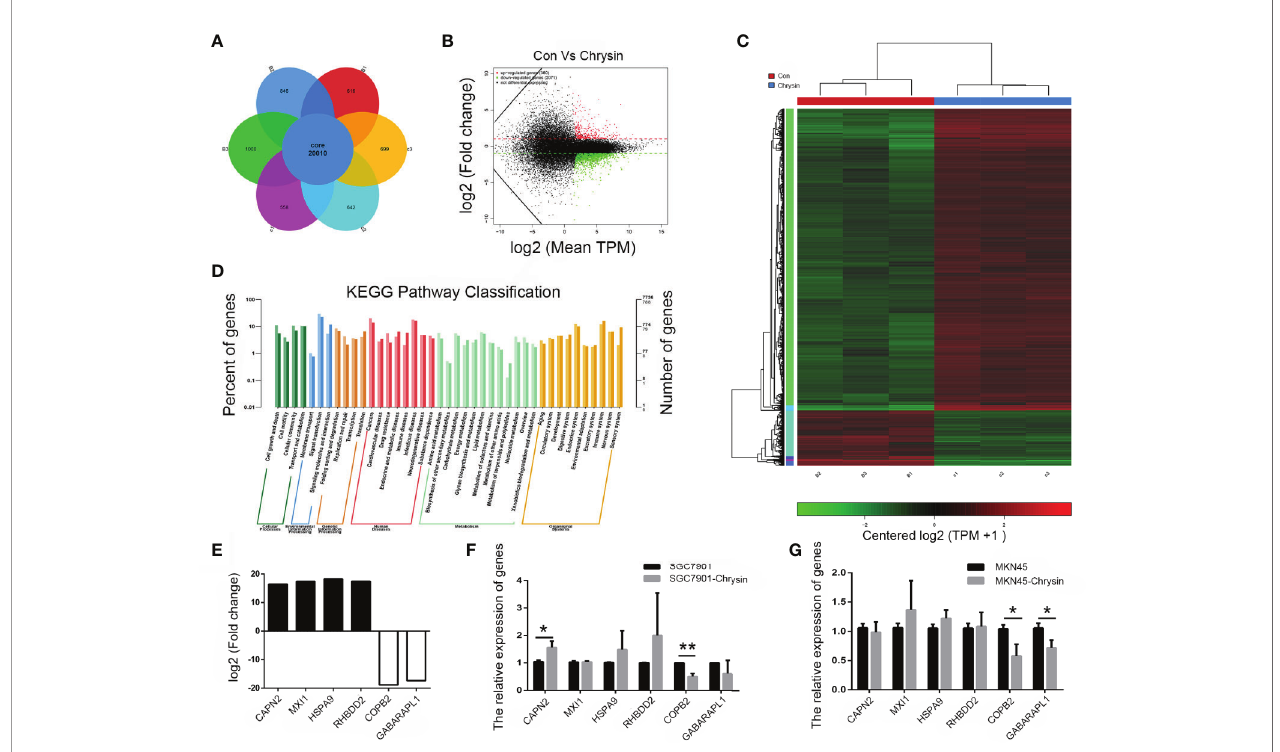
FIGURE 1 | Screening of differentially expressed genes by RNA-seq. Analysis of differential expressed genes after chrysin treatment (A) , Identi fi cation of different expressed genes (B) . The heatmap was drawn to show the differentially expressed genes (C) . KEGG pathway of the differentially expressed genes (D) . The expression of log2 fold change in six genes (E) . Relative expression of CAPN2 , MXI1 , HSPA9 , RHBDD2 , COPB2 and GABAPAPL1 were analyzed by qPCR after Chrysin treatment in SGC7901 (F) and MKN45 cells (G) . The data are represented as the mean ± SD (n = 3). * ( p < 0.05) and ** ( p < 0.01) indicate statistically signi fi cant